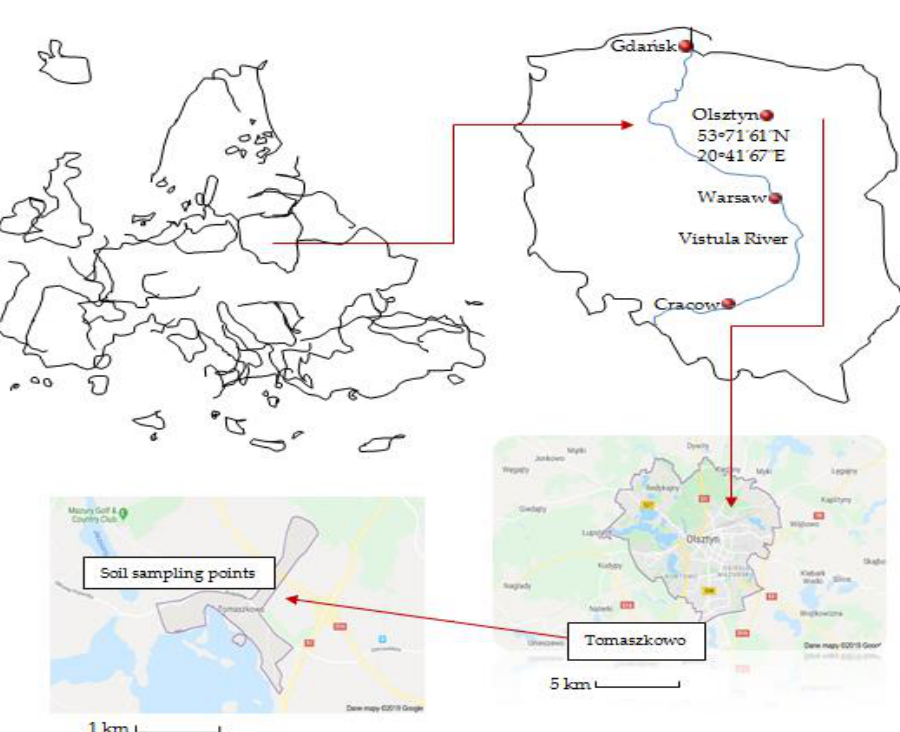
Figure 1. Location of the test site [15].